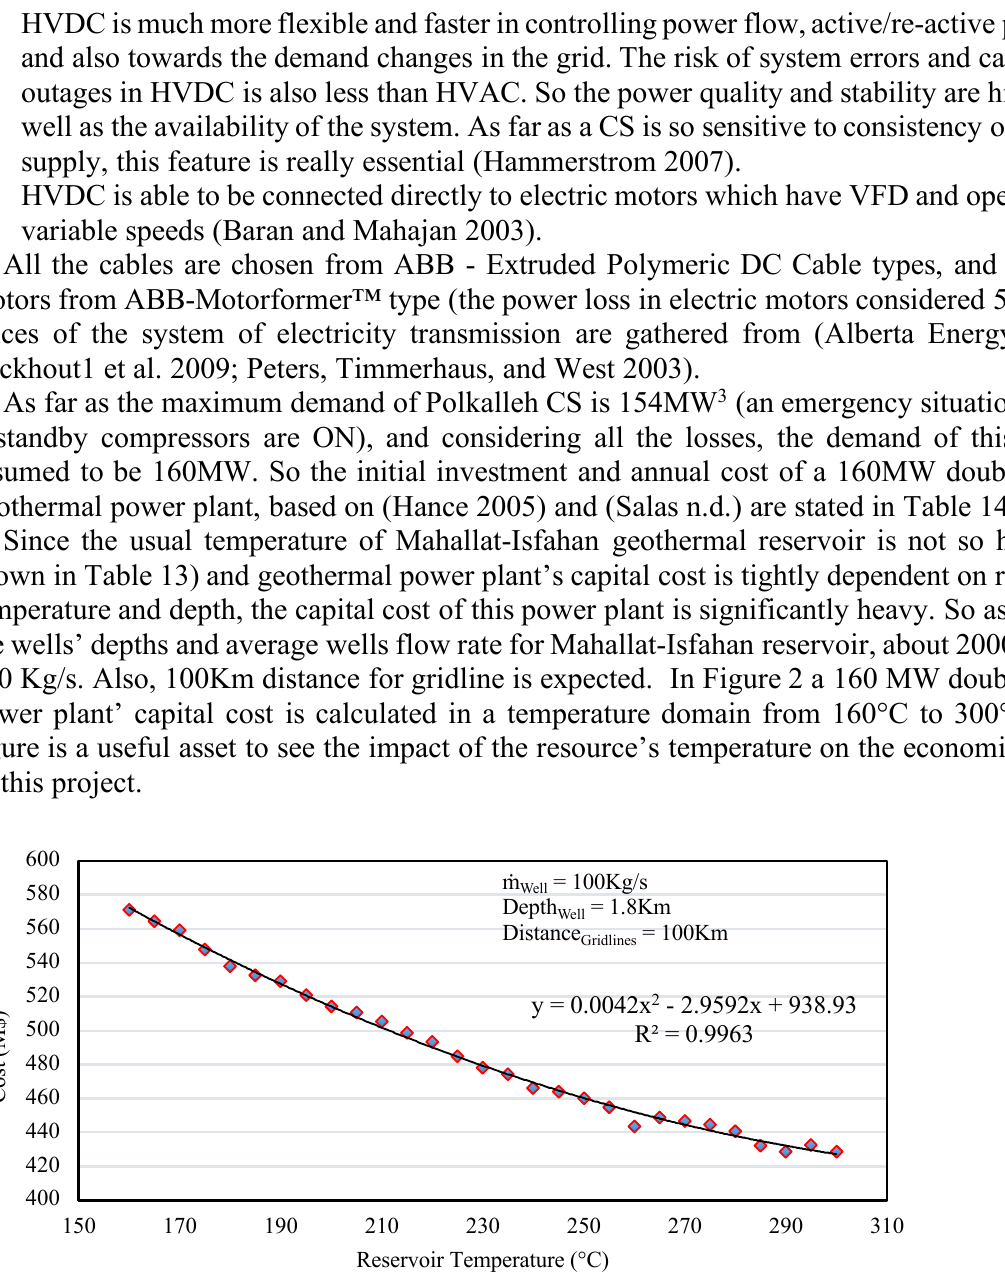
Fig 2. Capital investment in different reservoir temperatures for 160MW geothermal power plant Economic